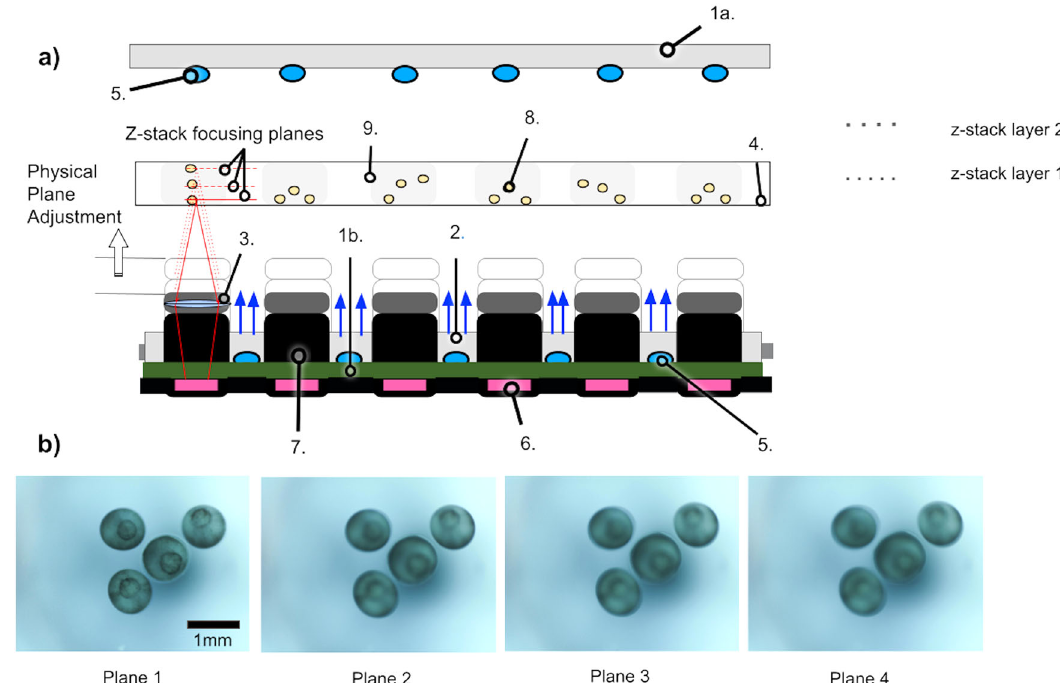
Fig. 4 Schematic representation of the z-stack function. a A single row of cameras demonstrating the z-stack function. 1.a = Over-the-plate illumination board, 1.b = Under-the-plate illumination board, 2 = Acrylic Light Diffuser, 3 = Lenses, 4 = Cell Culture Plate, 5 = LEDs, 6 = Raspberry Spy Cameras, 7 = 3D Printed Camera Bodies, 8 = Biological Sample (e.g., Frog Embryos), 9 = Individual Culture Well. b Four focal planes of a single z-stack. These photos at were taken at four planes, 0.3 mm apart. The blastopore is only in focus in Plane